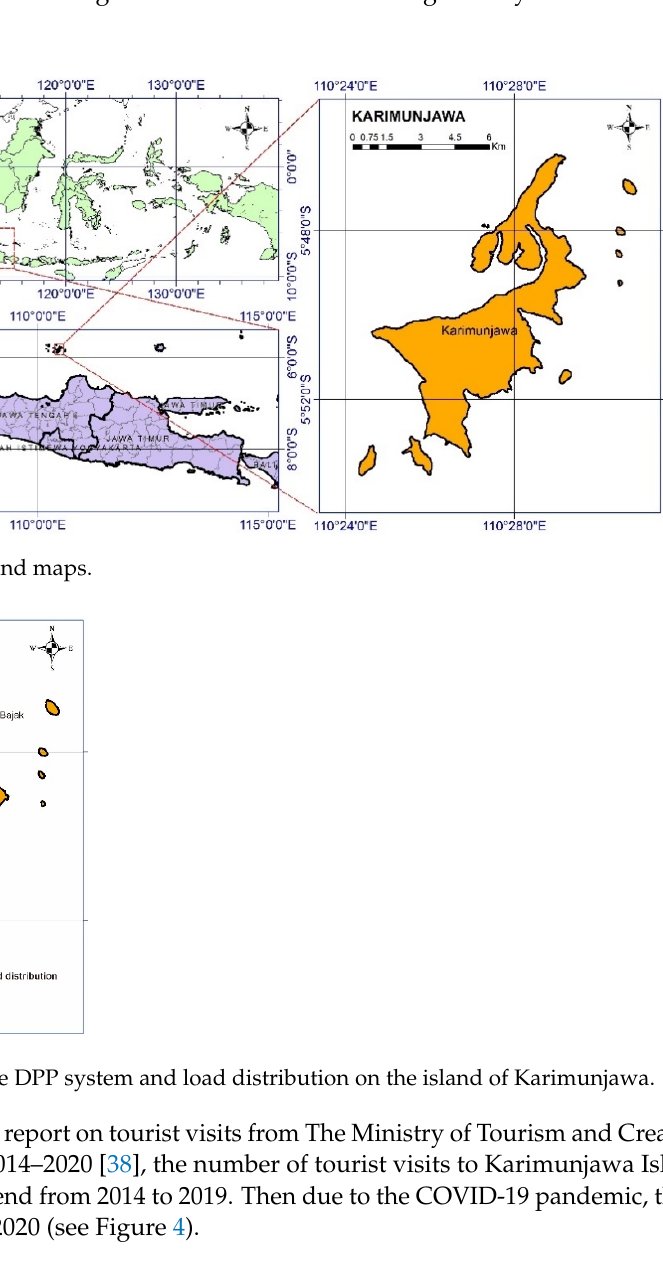
Figure 4. Tourist visit to Karimunjawa Island 2014–2020.